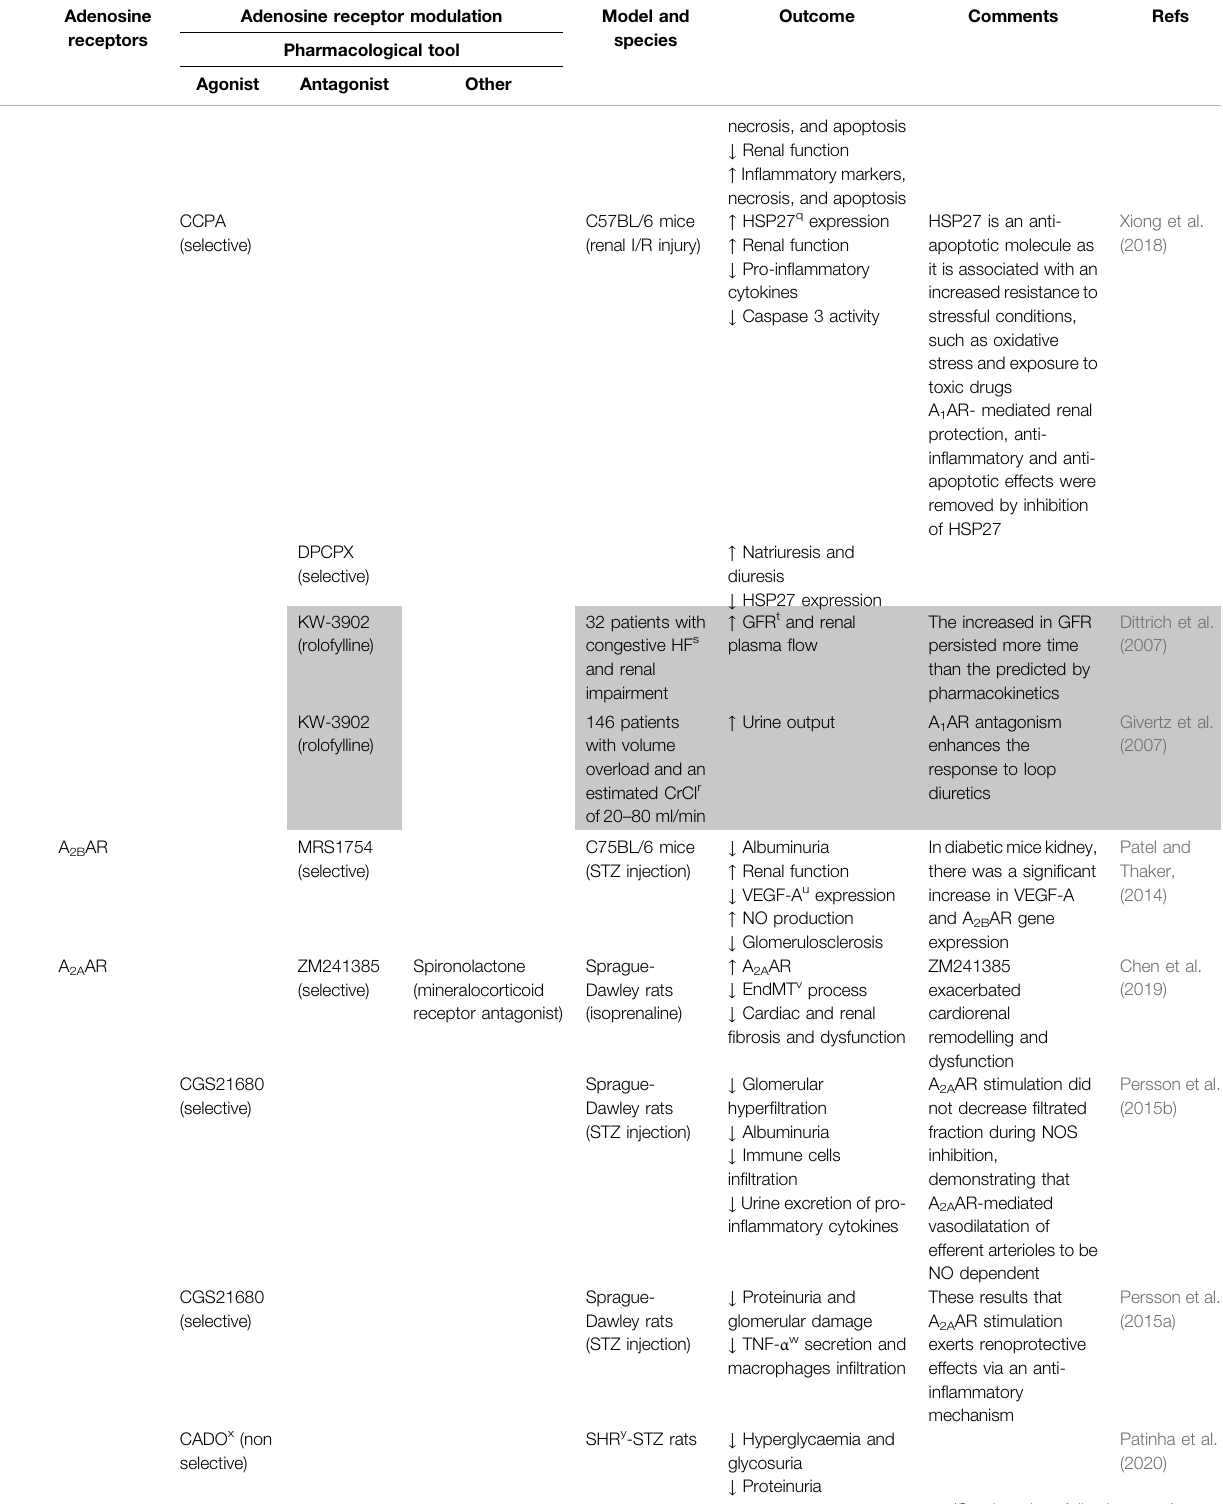
TABLE 2 | ( Continued ) Results of adenosine receptors agonism/antagonism in diabetes mellitus/obesity and chronic kidney disease. Different agonists/antagonists were used to assess its effects on HFpEF comorbidities. The grey area corresponds to studies carried out in human